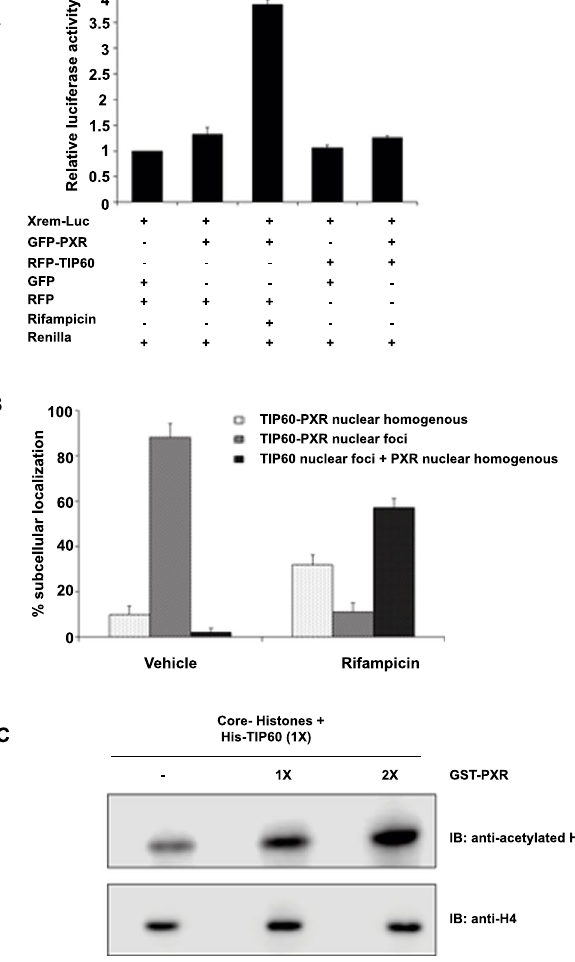
Figure 6. TIP60-PXR complex does not stimulate PXR-mediated transactivation. ( A ) Cos-1 cells were transfected with RFP-TIP60, GFP-PXR and XREM-Luc (containing luciferase gene under PXR targeted gene CYP3A4 promoter) plasmids and empty vectors as indicated in the figure. Rifampicin (10 µ M) was added as PXR agonist. Dual-Glo luciferase assay was performed with the transfected cell lysates. Firefly luciferase values were normalized to the corresponding Renilla luciferase signal for transfection efficiency. The graph represents the normalized mean values ( ± SD) of three independent set of experiments performed in triplicate. ( B ) TIP60- PXR complex is sensitive to PXR agonist. To observe the effect of PXR ligand on TIP60-PXR foci formation, Cos-1 cells cotransfected with RFP-TIP60 and GFP-PXR were treated with vehicle (DMSO) or rifampicin (10 µ M) and subcellular localization was monitored and recorded by fluorescence microscope. At least 100 transfected cells were counted and graph was plotted for the mean value of three independent experiments with ± SD. ( C ) TIP60 HAT activity is augmented in presence of PXR. Purified recombinant His-TIP60 and GST-PXR proteins were used for in vitro HAT assay using core histones as substrate. Proteins were resolved by 15% SDS-PAGE followed by immunoblotting with indicated antibodies. Full-length immunoblots are presented in Supplementary Figure